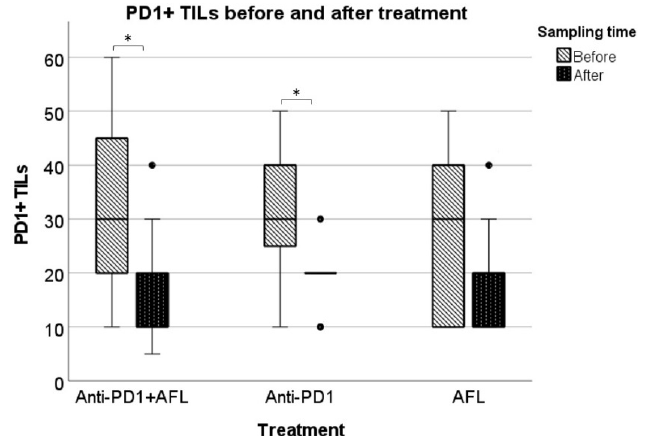
Figure 2. PD1+ TILS in the three intervention groups before and after intervention measured in